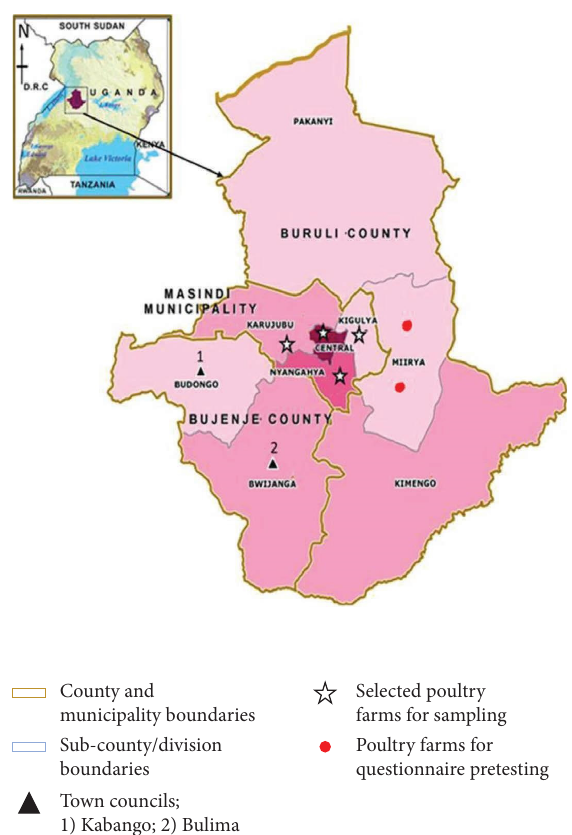
Figure 1: Map of Masindi district showing Masindi municipality (study area), Bujenje and Buruli counties. Adopted from Uganda Bureau of Statistics